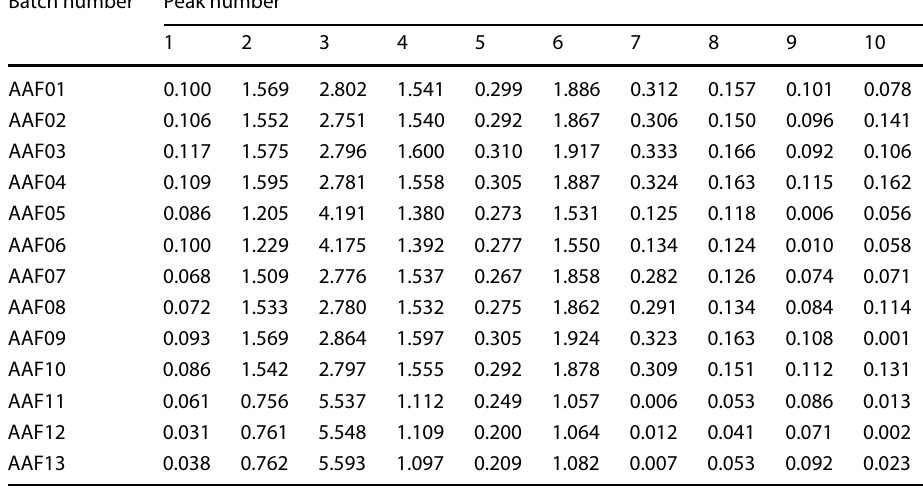
Table 3 Correlation coefficients for relationships between characteristic peaks and xanthine oxidase inhibition